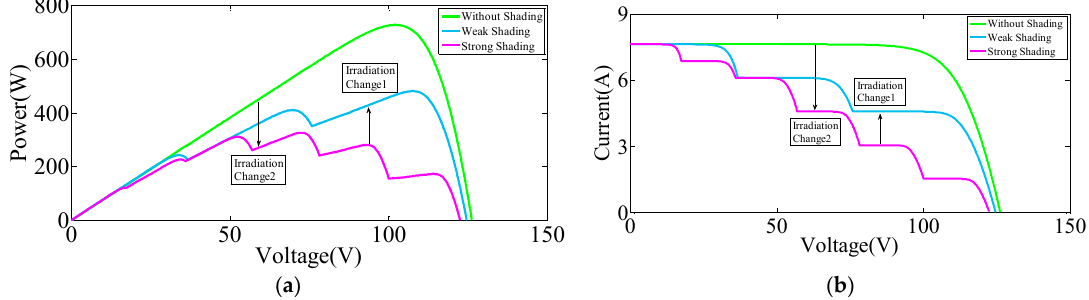
Figure 10. The output characteristics of the PV array for change shading ( a ) P-V curve; ( b ) I-V curve.